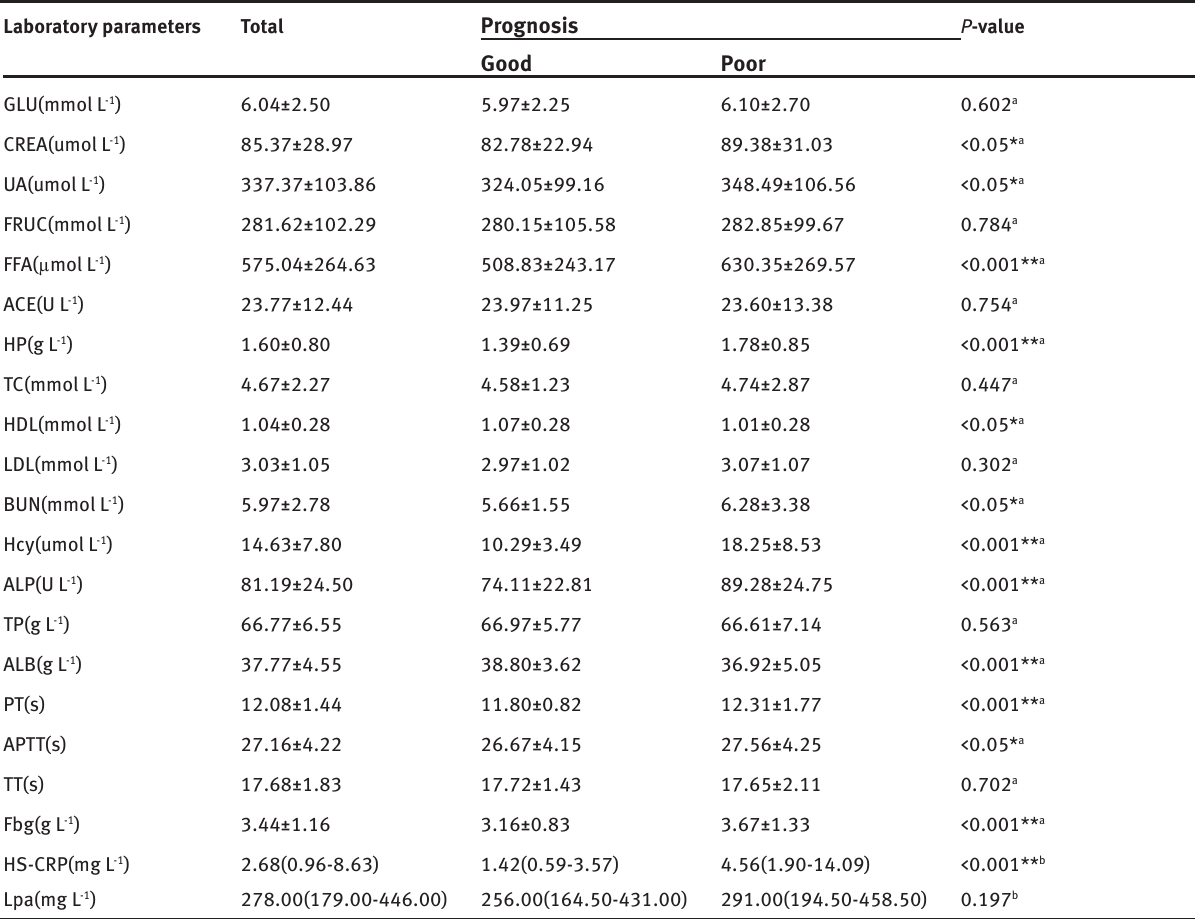
Table 2: Laboratory parameters of patients with acute ischemic stroke Laboratory parameters